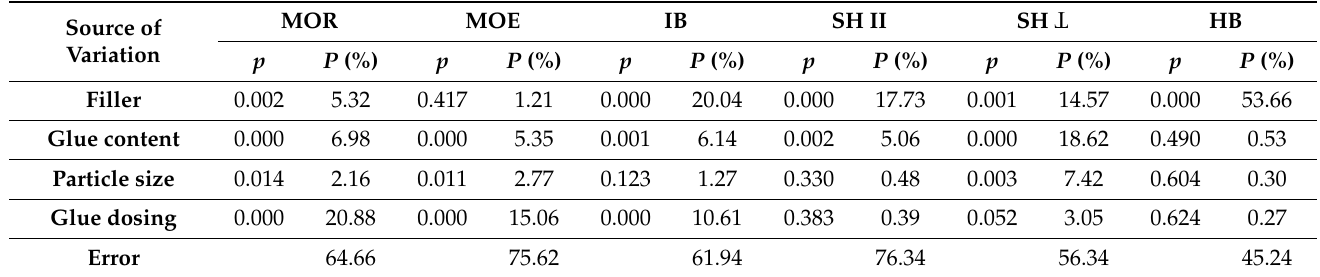
Table 2. ANOVA for selected factors affecting the MOR, MOE, IB, SH, and HB of the manufactured particleboards ( p = probability of non-significant effects, P = percentage